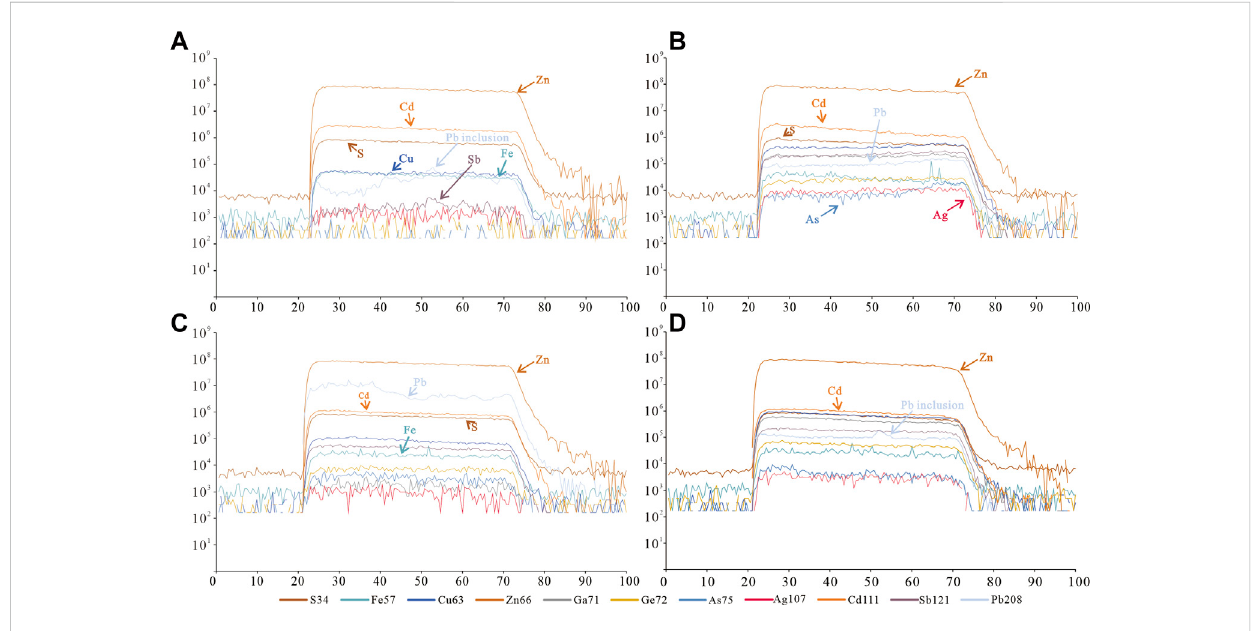
FIGURE 7 Representative time-resolved LA-ICP-MS depth pro fi les for sphalerite.